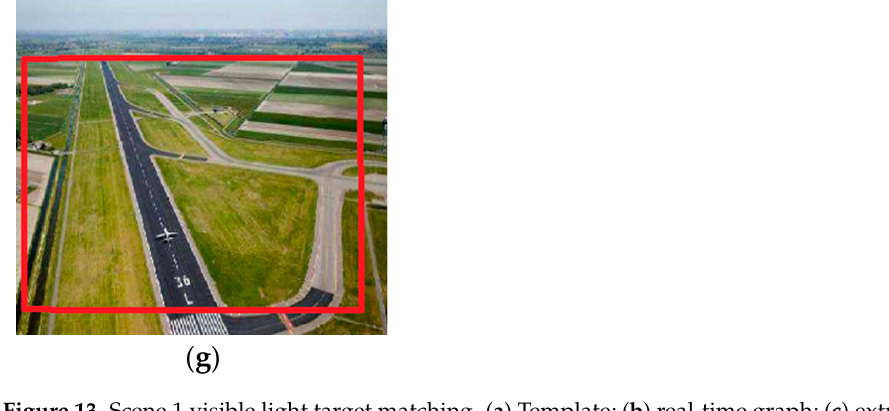
Figure 13. Scene 1 visible light target matching. ( a ) Template; ( b ) real-time graph; ( c ) extract green lines from templates in Scene 1; ( d ) extract red lines from real-time graphs in Scene 1; ( e ) red box position in template in Scene 1; ( f ) red box position in real-time map in Scene 1; ( g ) red box position of SURF in Scene 1.